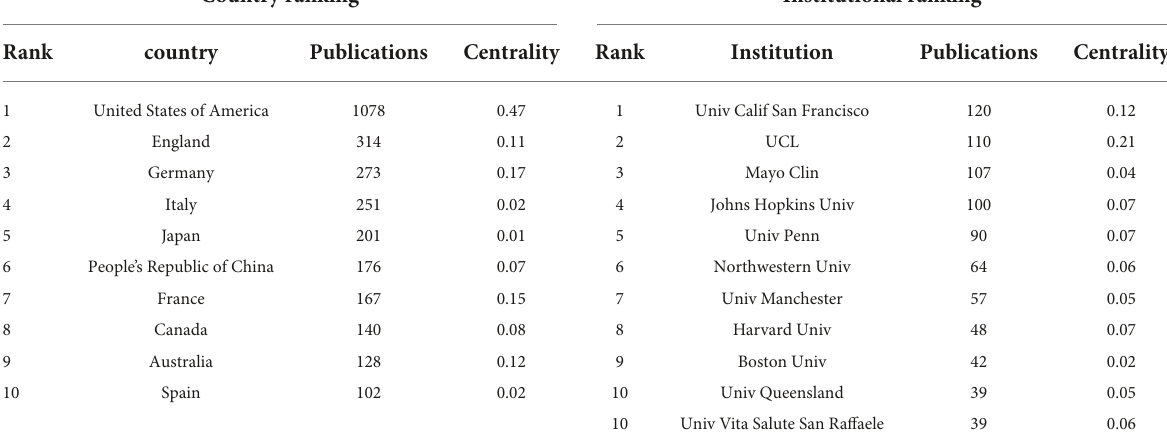
TABLE 1 Top 10 countries and institutes publishing research on neuroimaging research of aphasia.